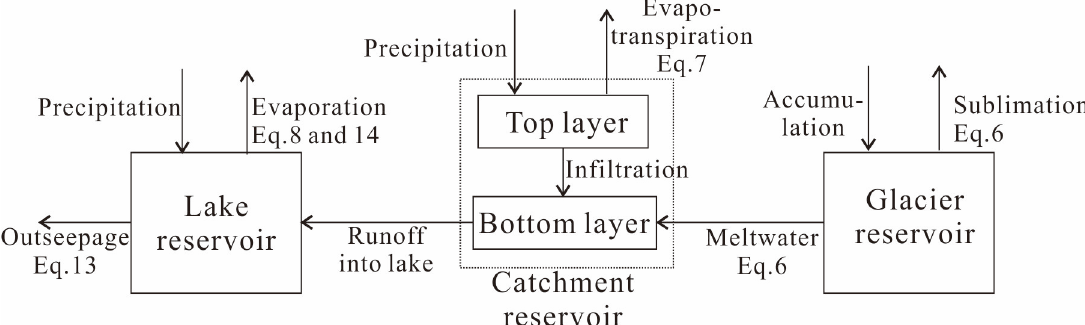
Figure 2. Simplified structure of the lake model. The numbers of each flux correspond to the equations in the text.